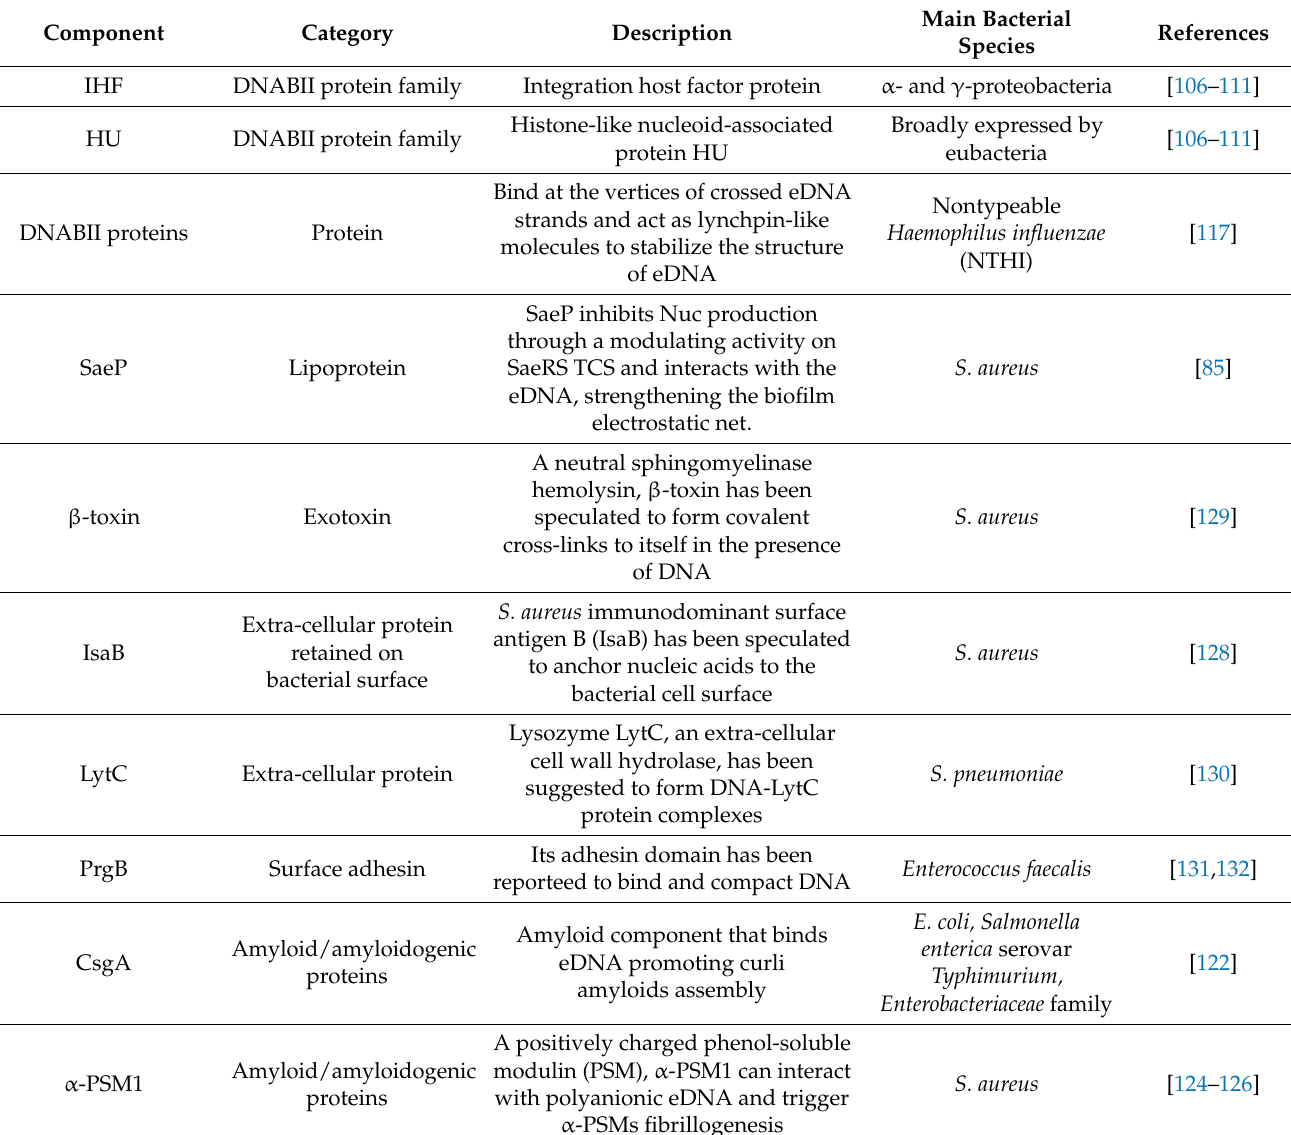
Table 2. Proteins interacting with eDNA in the biofilm